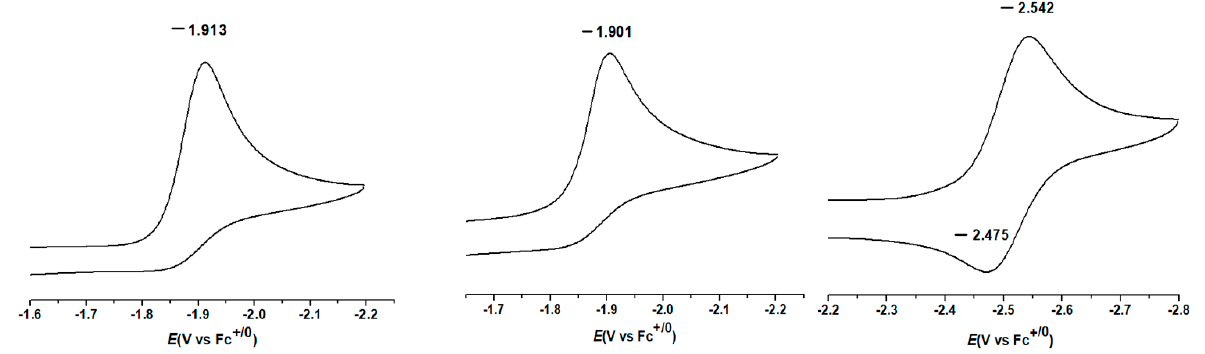
Figure 5. Cyclic voltammetry (CV) of A, B, and BH NPF as supporting M n-Bu 4 6